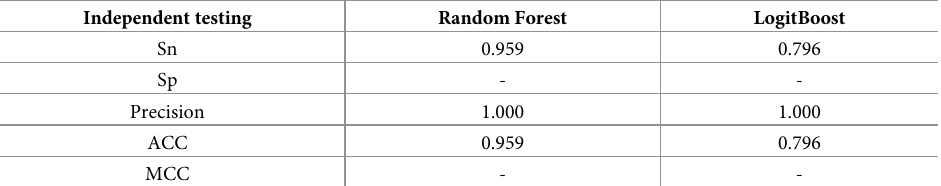
Table 8. Predicting results of the best classifier of stage 2 classifiers with cross-validation and independent